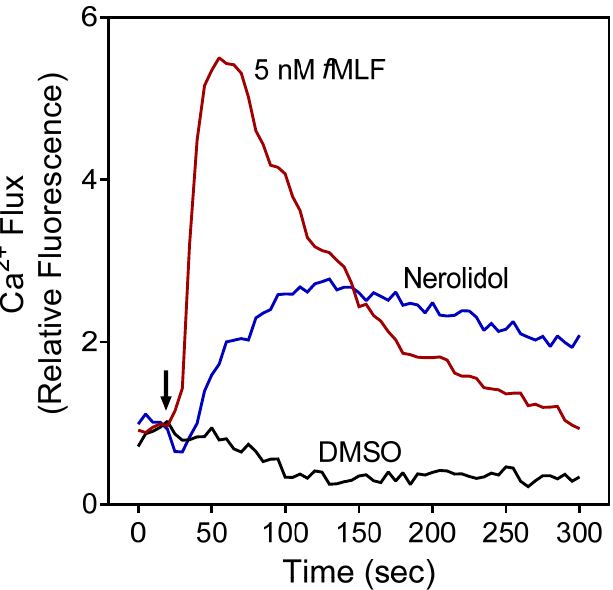
Figure 1. Effect of nerolidol on neutrophil [Ca 2+ ] i . Human neutrophils were treated with 5 µM nerolidol, 5 nM f MLF (positive control), or 1% DMSO (negative control), and [Ca 2+ ] i was monitored for the indicated times (arrow indicates when treatment was added). Data are from one experiment that is representative of three independent experiments.